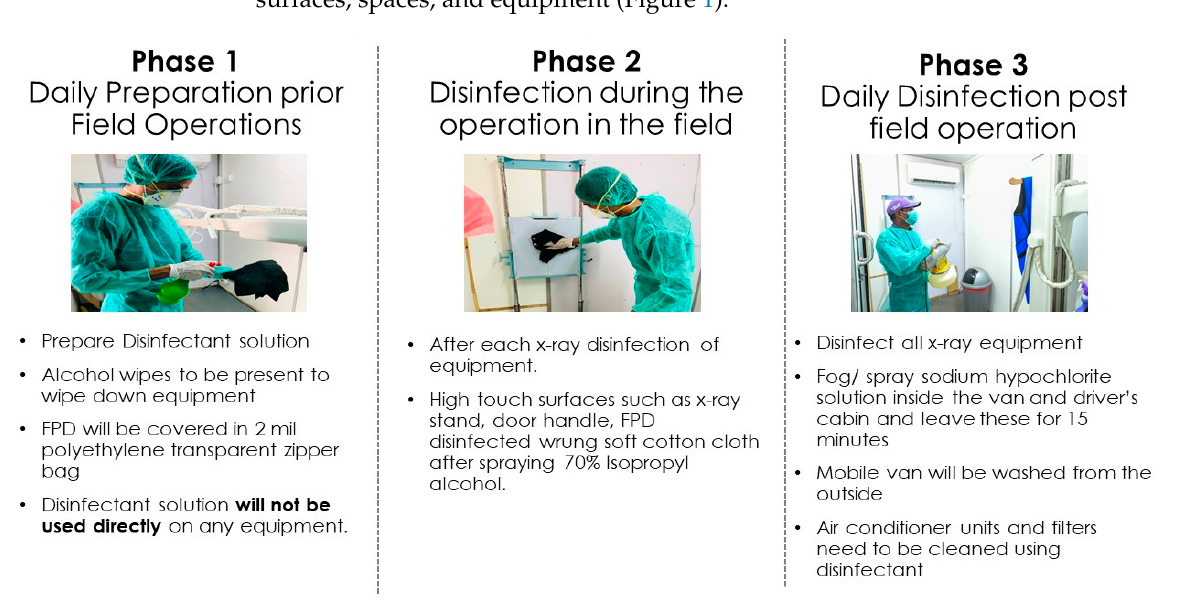
Figure 1. Mobile X-ray van disinfection protocol to ensure patient safety.